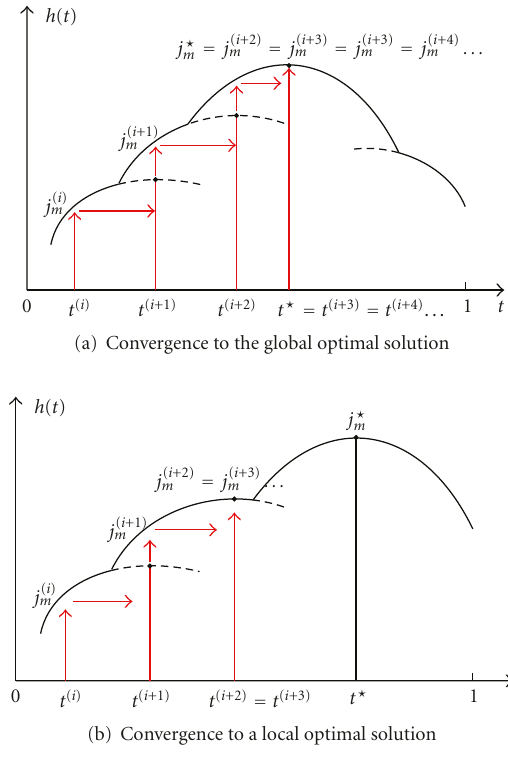
Figure 2: Convergence of APD